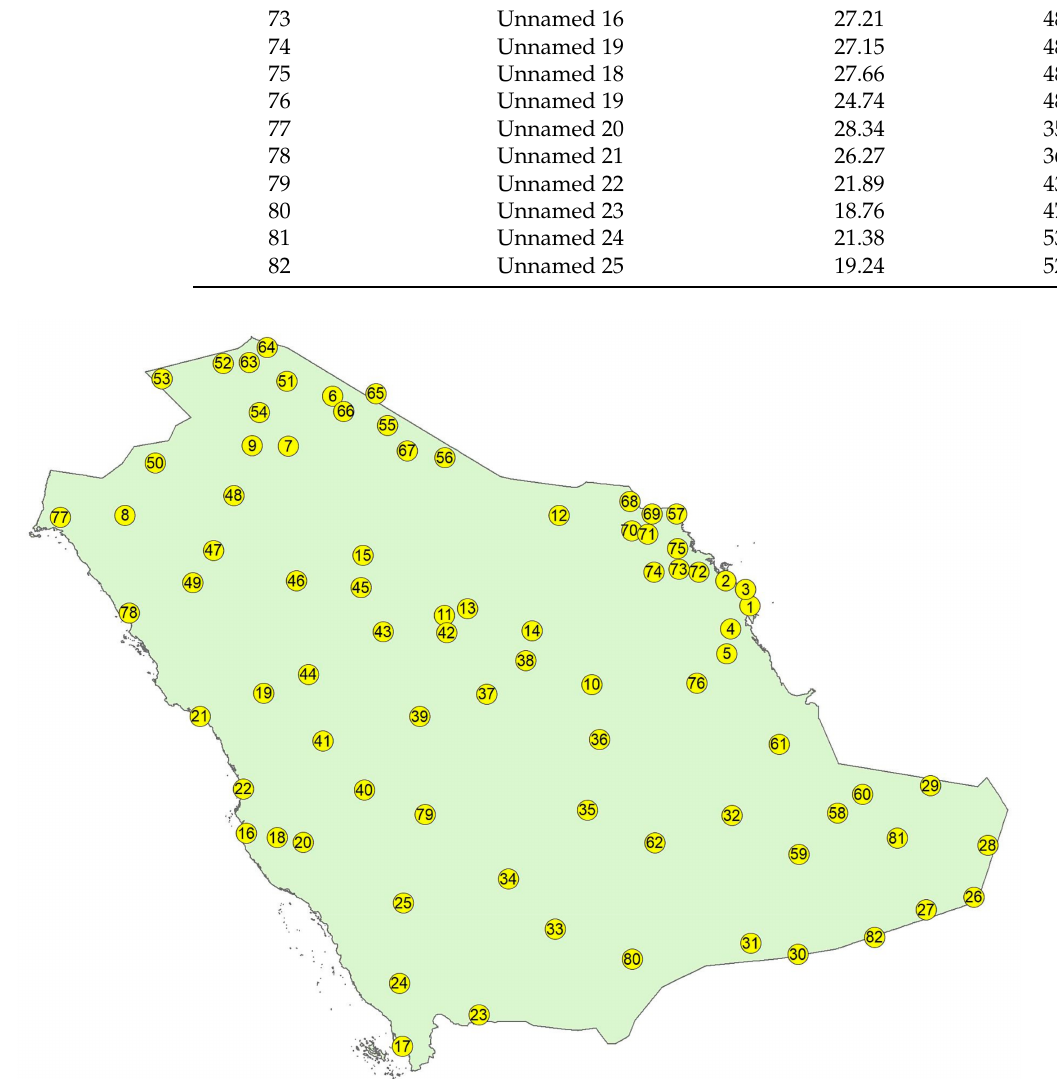
Figure 1. Distribution of the selected 82 locations in Saudi Arabia. The numbers in the circles refer to those in column 1 of Table 1. This figure is reproduction of Figure 1 in